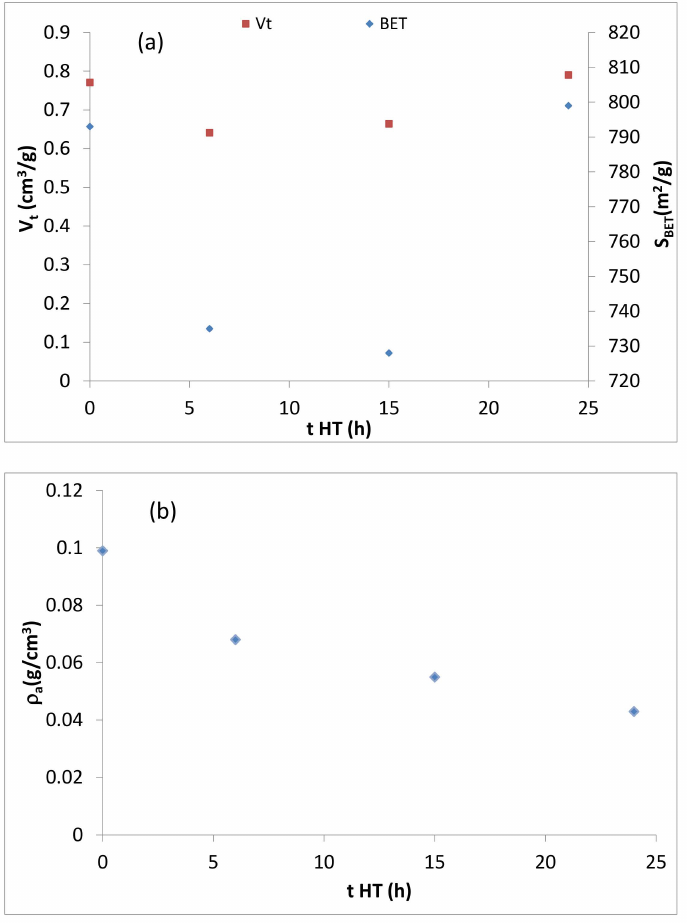
Figure 4. Variation with the hydrothermal treatment time (tHT) of: ( a ) total volume (V t ) and BET area (S BET ) and ( b ) apparent density ρ a